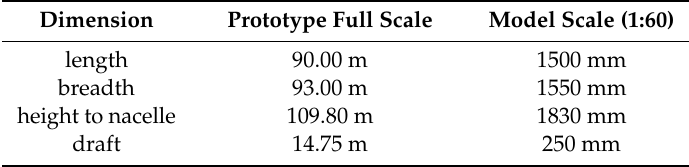
Table 2. Main dimensions of the floater.